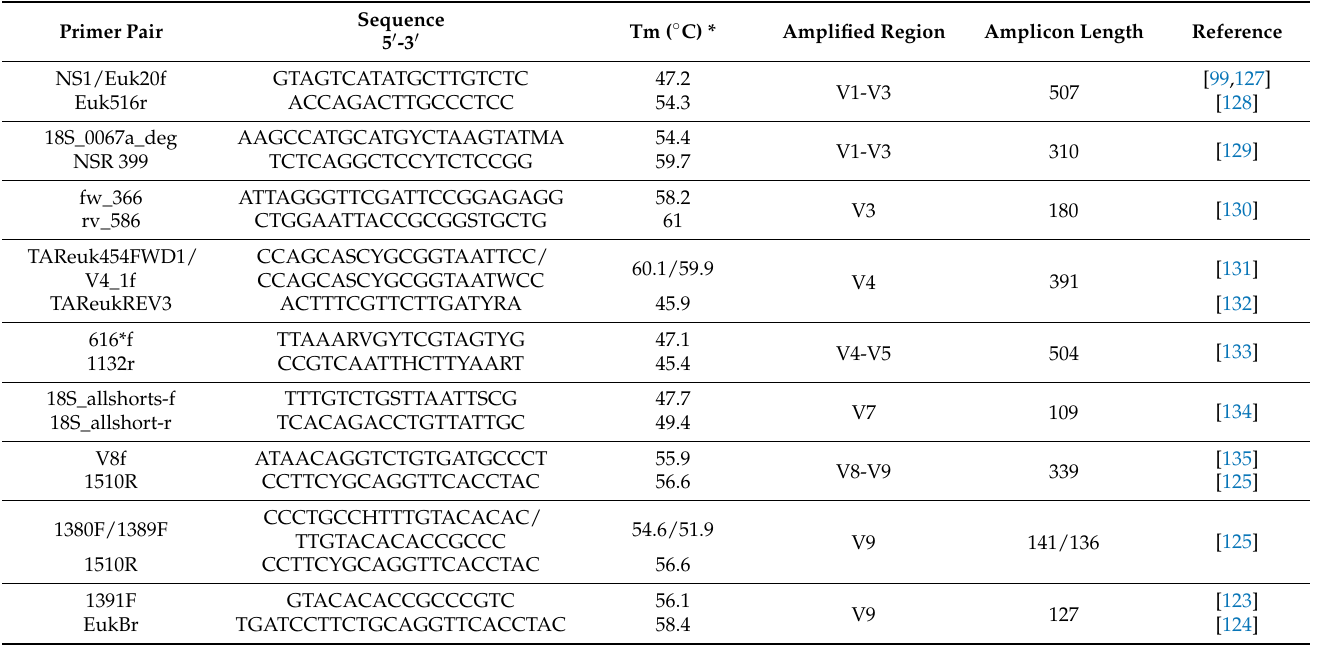
Table 5. Primer pairs targeting the 18S rRNA gene that have been frequently used to characterize protists biodiversity in studies based on Illumina